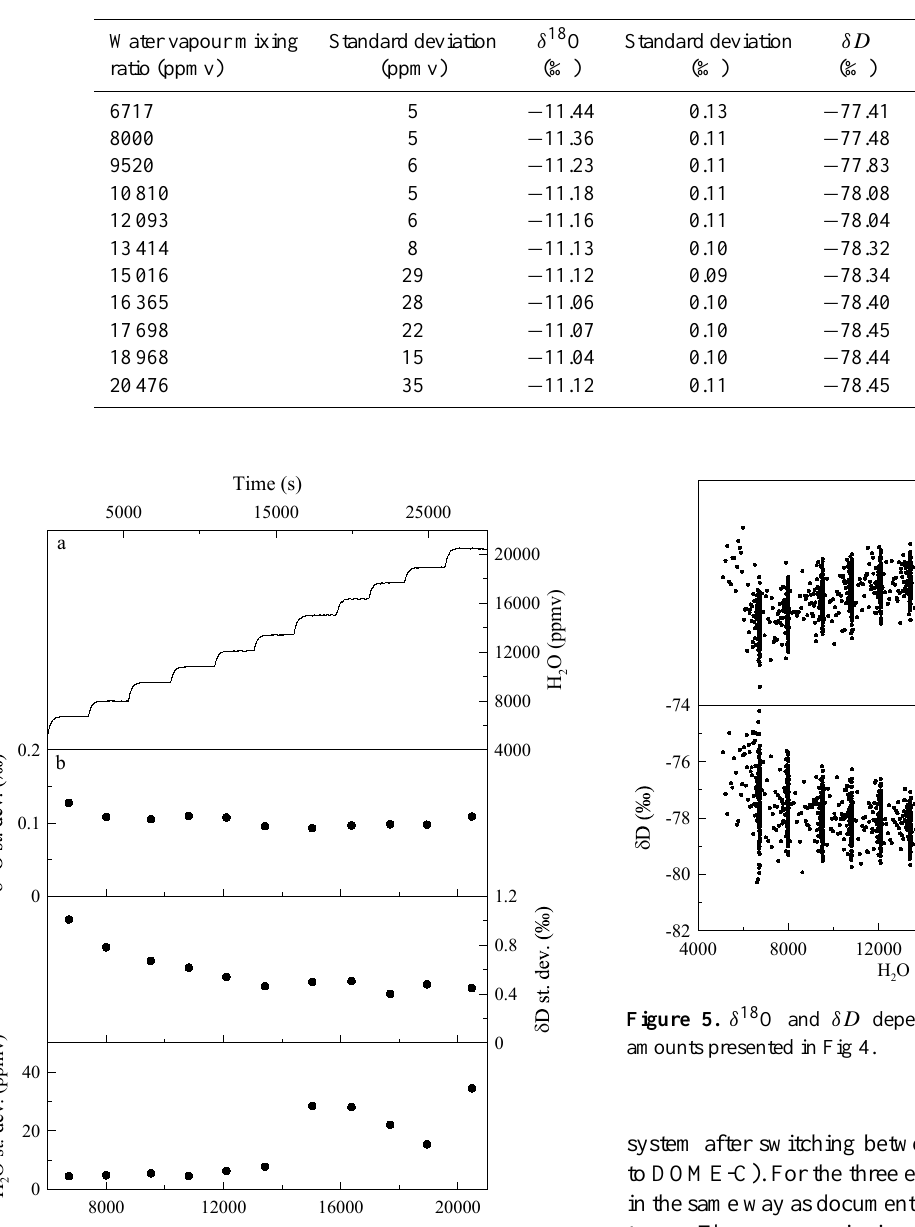
Table 2. Effect of the water vapour mixing ratio on δD and δ 18 O measurement vs. VSMOW based on 40min measuring intervals per water level.